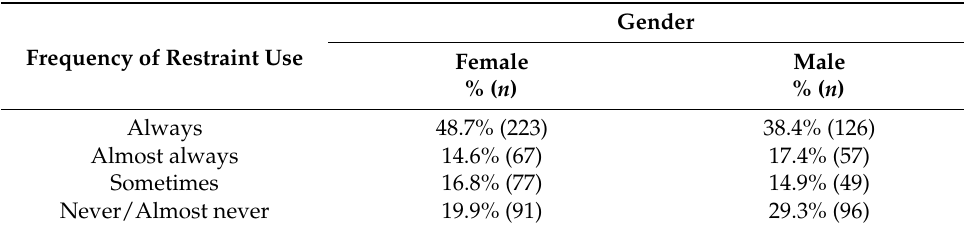
Table 3. Participants’ gender and frequency of restraint use for their eldest child while travelling in a motor